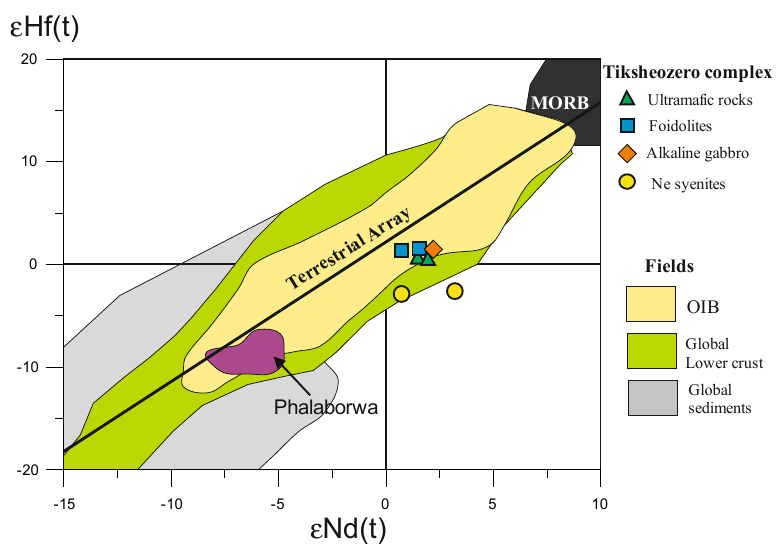
Figure 5. Hf − Nd isotope diagrams for rocks of the Tiksheozero massif. Fields of MORB, OIB, global lower crust and sediments are from [38,39]. The Terrestrial Array is from [40]. Field for the Phalaborwa massif is shown after [39]. For symbols, see Figure